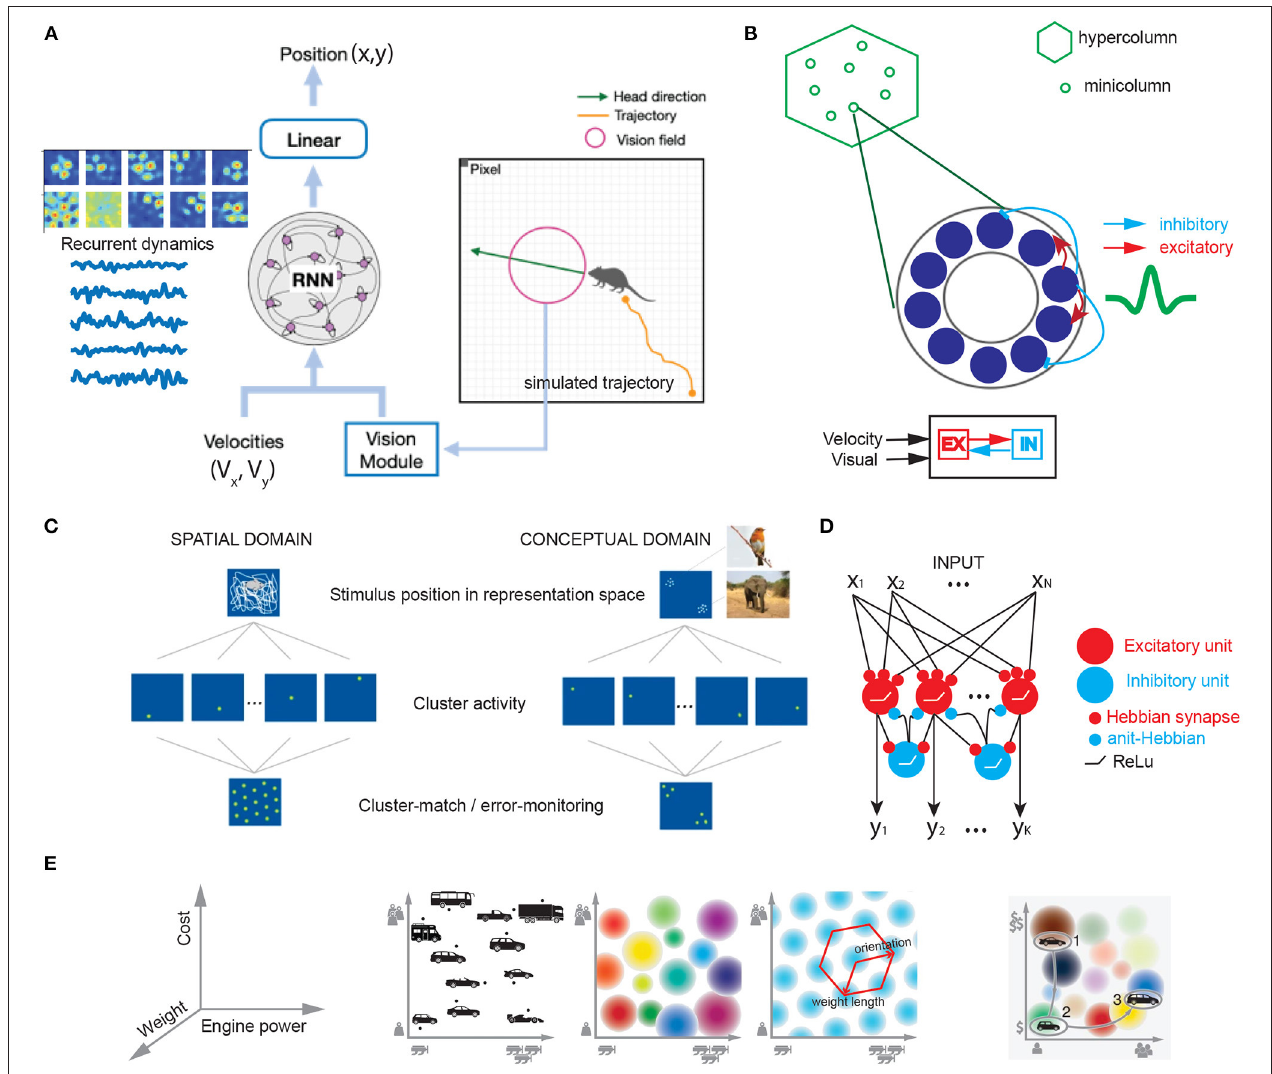
FIGURE 2 | Computational models that explain grid-like computation in spatial and conceptual domains. (A) To model the grid cells in the rat V2 visual cortex, we trained an excitatory-inhibitory (E/I) recurrent neural network (RNN) using both velocity input (V x , V y ) and visual input of varying dimension (based on dimensionality reduction from PCA) to decode a simulated agent’s trajectory (x,y) in an open field environment. Emergent grid-like responses were found in the RNN’s hidden units (Z.S. Chen, Data unpublished). (B) A schematic of continuous attractor model for V2 grid cells based on excitatory-inhibitory neuron population interaction. (C) Schematic of clustering in spatial and conceptual domains based on the cluster-monitoring/error-monitoring mechanism (figures are modified from Mok and Love, 2019, Nature Communications ; reprinted with permission, from the authors and Springer Nature). (D) E/I feedforward neural network for clustering or learning similarity-preserving map based on local Hebbian rules (Sengupta et al., 2018). (E) Illustration of grid cells in cognitive space. Left: 3D feature space that defines independent dimensions satisfying geometric constraints for vehicle. Middle left: 2D space spanned by the dimensions of engine power and car weight. Middle center: Multiple place cells with different firing fields. Middle right: single grid cell with regular periodic firing field. Right: Navigation in a continuous cognitive “car” space (figures are modified from Bellmund et al., 2018a, Science ; reprinted with permission, from AAAS).